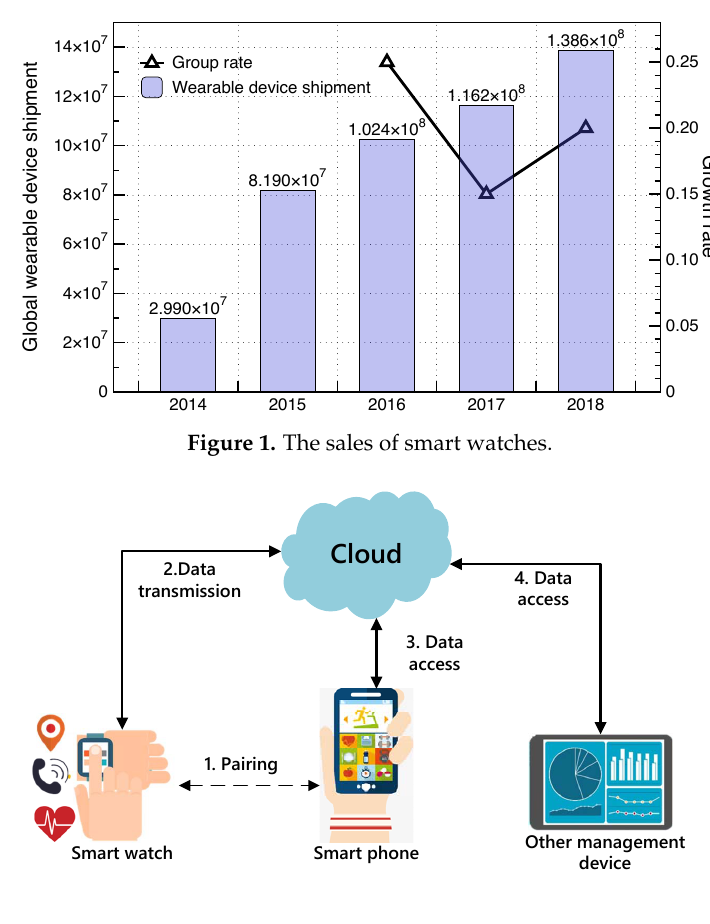
Figure 2. The information interaction process of the smart wearable